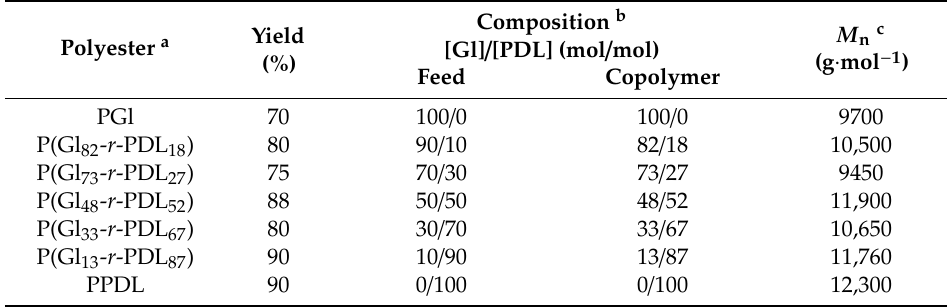
Table 1. Yield, composition, and molecular weight of the P(Gl x - r -PDL y ) copolyesters.